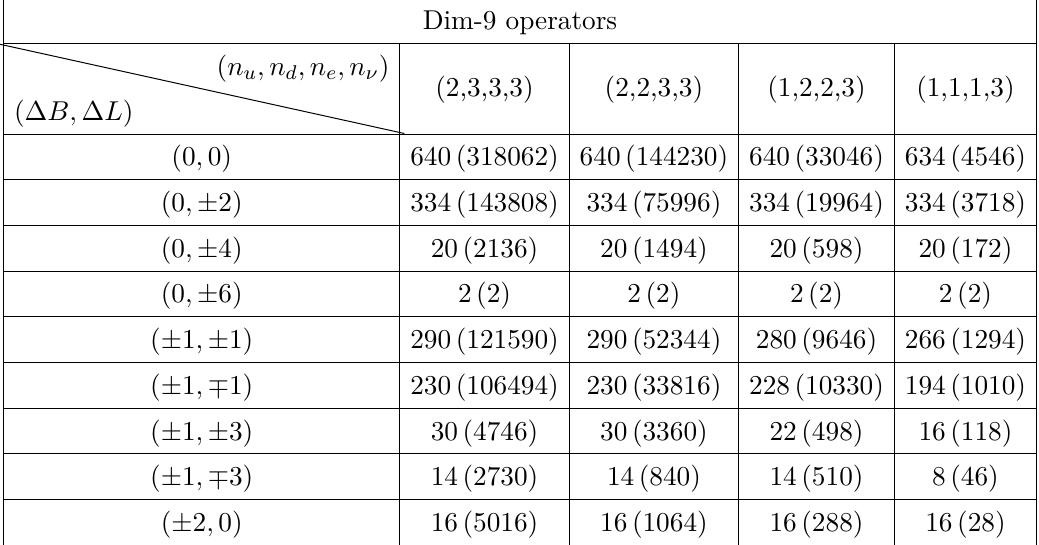
Table 8 . The number of types (operators) of each baryon-number and lepton-number violation pattern with various flavor numbers at dimension 9. n of up-type quarks, down-type quarks, charged leptons and neutrinos respectively. For n n u = 1 , the corresponding active up-type quarks are ( c, u ) and ( u ) respectively, For n d = 3 , 2 , 1 , active down-type quarks are ( b, s, d ) , ( s, d ) and ( d ) respectively, n charged letpons ( τ, µ, e ) , ( µ, e ) and ( e )